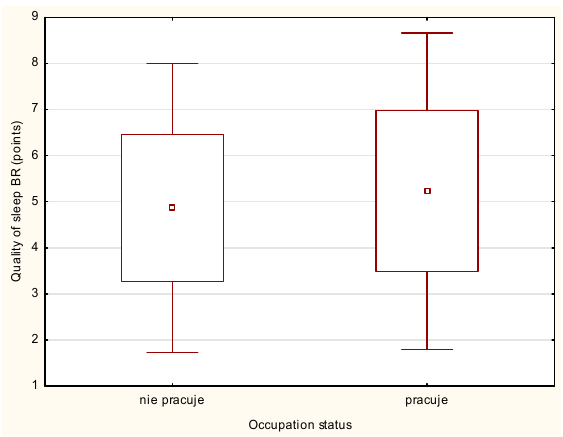
Figure 2. Quality of sleep according to the occupational status BR.